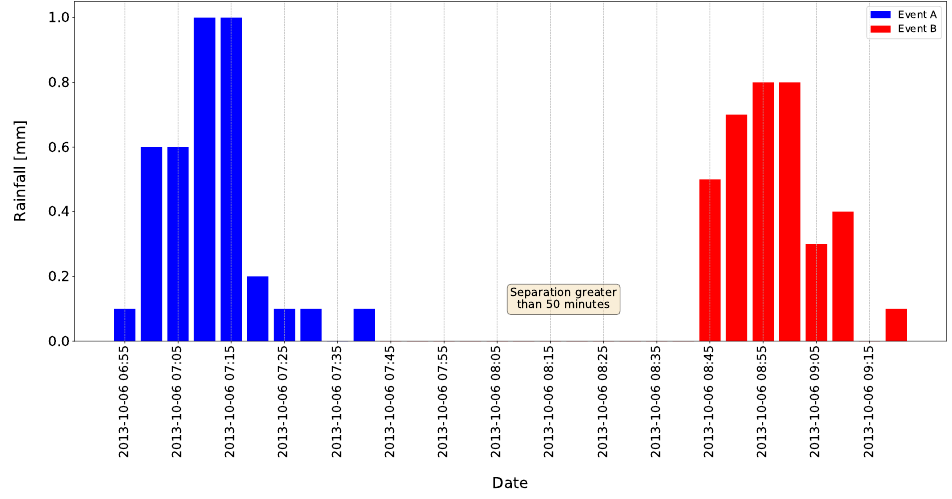
Figure 3. Example of two different events from station P28. Definitions and procedures from Algorithm 2 allows us to automatically capture events of different